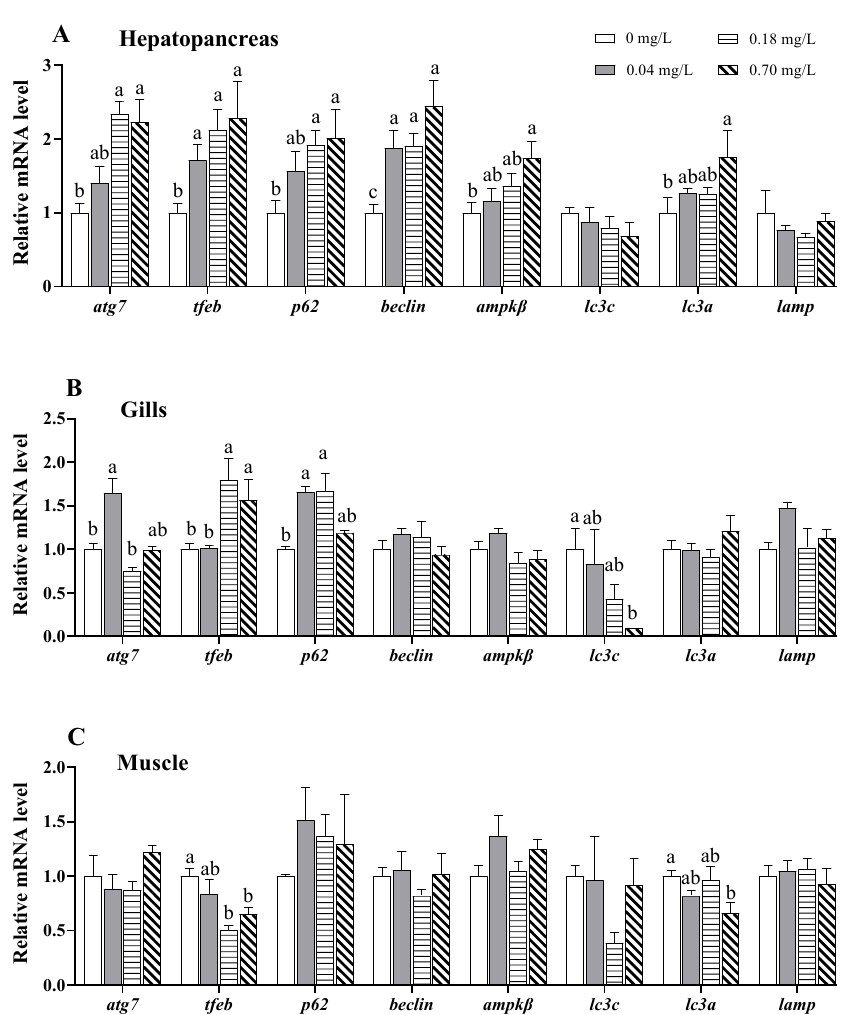
Figure 6. Expression of autophagy-related genes in different tissues of E. sinensis exposed to copper for 5 days. ( A ) Hepatopancreas; ( B ) gills; ( C ) muscle. The values are expressed as the mean ± SEM ( n = 6). Different letters denote significant differences among different groups ( p < 0.05).